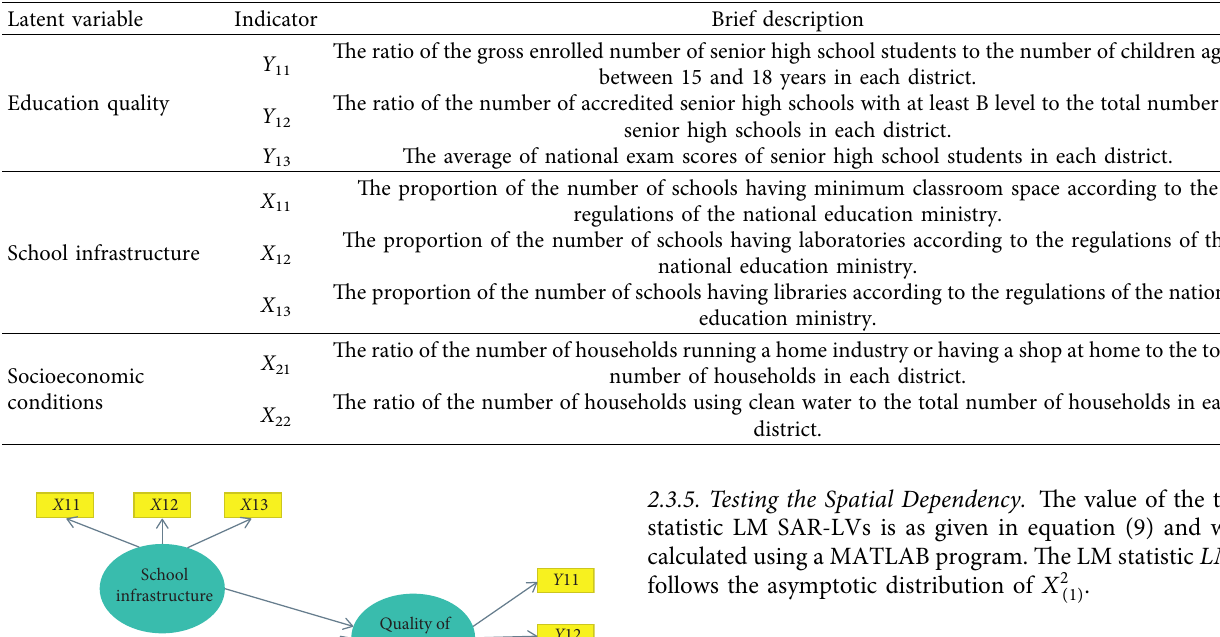
Table 1: Latent variables and their indicators.